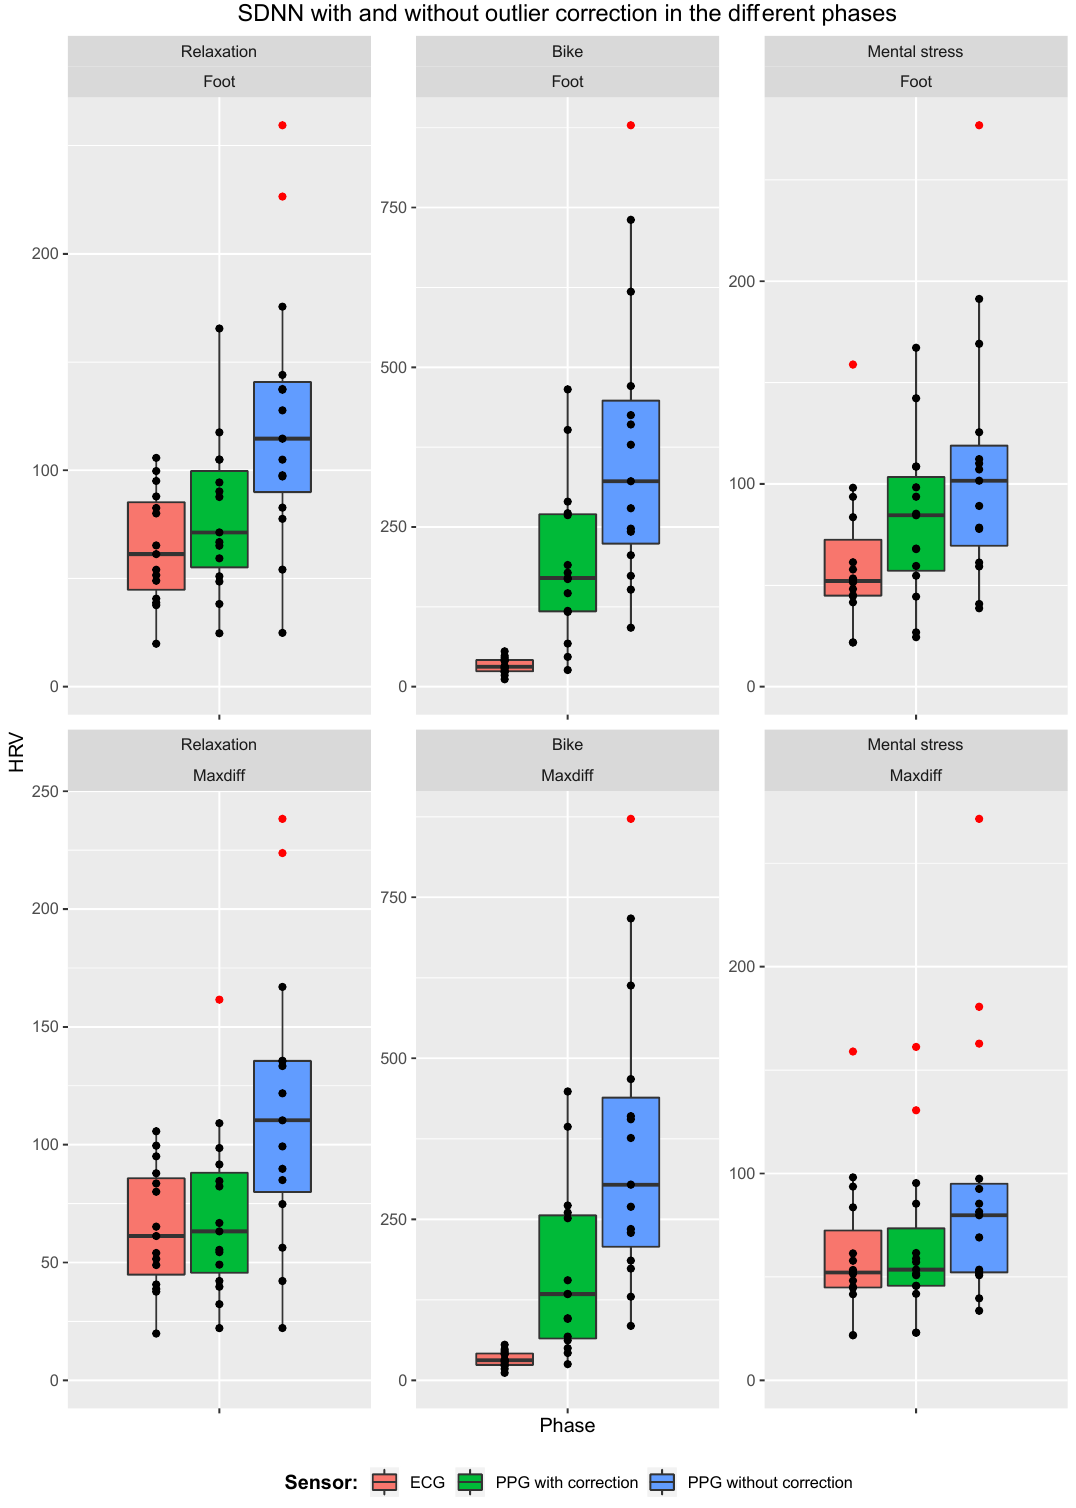
Figure 7. The spread of SDNN for the 15 participants measured with ECG and PPG with and without outlier correction, broken down by the different phases and fiducial points (foot and maxdiff). Outliers are shown in red. Comparing the fiducial points, the Max slope method gave consistently a better agreement than the Foot